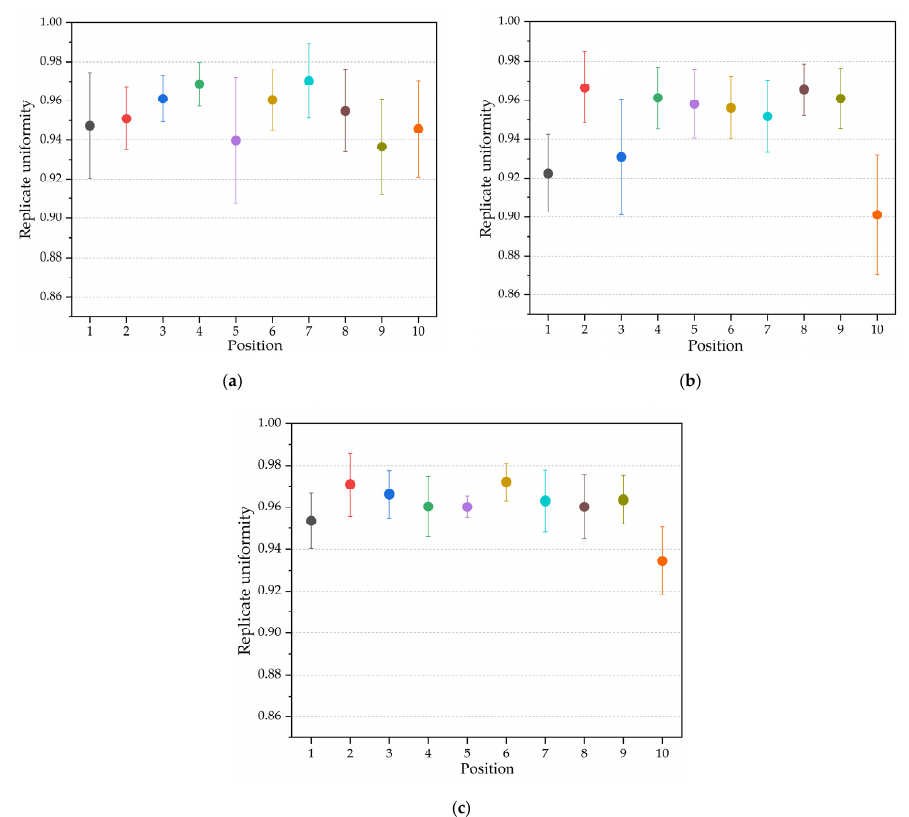
Figure 6. Replicate uniformity: ( a ) cavity thickness is 0.3 mm; ( b ) cavity thickness is 0.5 mm; and ( c ) cavity thickness is 0.7 mm. Figure 6 exhibits the variation of the replication uniformity along the diameter. The abscissa axis represents the position of the measured microstructure and the vertical axis represents the replication uniformity. It can be seen that the uniformity for each position is mostly above 0.9, especially when the cavity thickness is 0.7 mm. When the cavity thick- ness is 0.7 mm, the fluctuation range of the replication uniformity at each position is sig- nificantly smaller than at the thicknesses of 0.3 mm and 0.5 mm, indicating that the in- crease in the cavity thickness can reduce the influence of the process parameters on the replication uniformity.